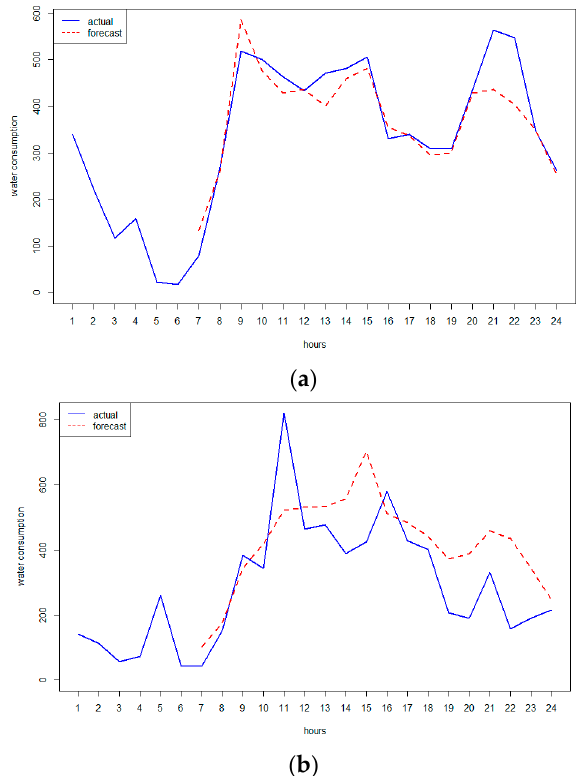
Figure 15. MAPE over the observation period for the non-residential “mixed” case (Case 3).